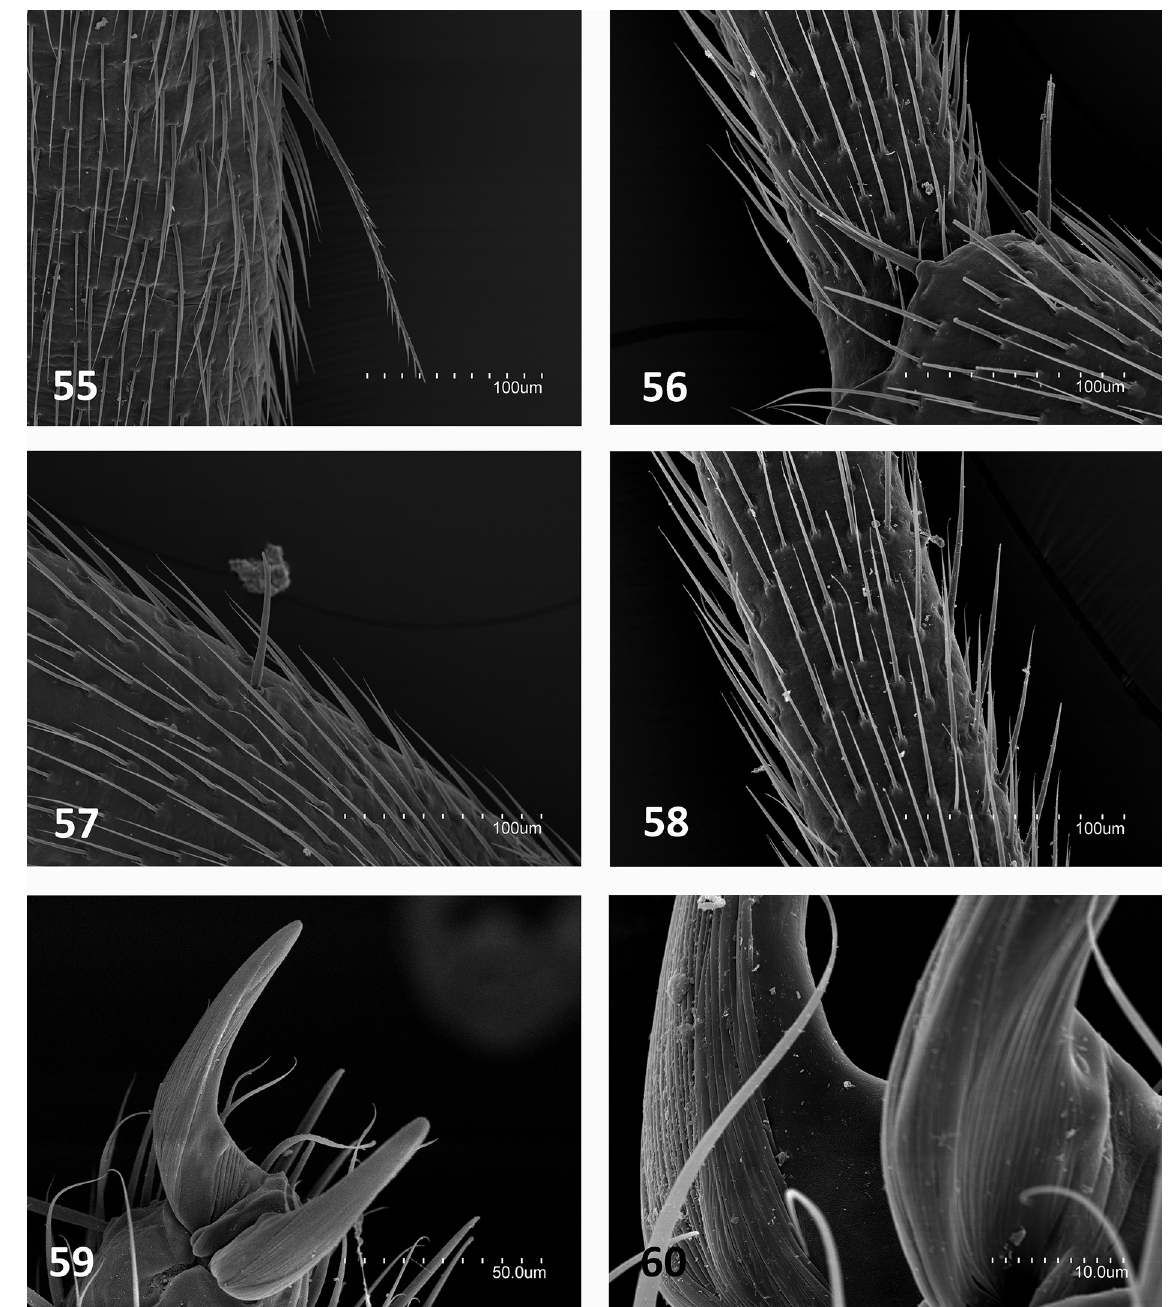
Figs 55‒60. Pacificampa wudonghuii Sendra sp. nov. 55 . Dorsal macrosetae on the metathoracic femur. 56 . Joint between tibia and tarsus with calcars. 57 . Ventral macroseta on the tibia. 58 . Lateral side of the tarsus. 59 . Pretarsus. 60 . Detail of the